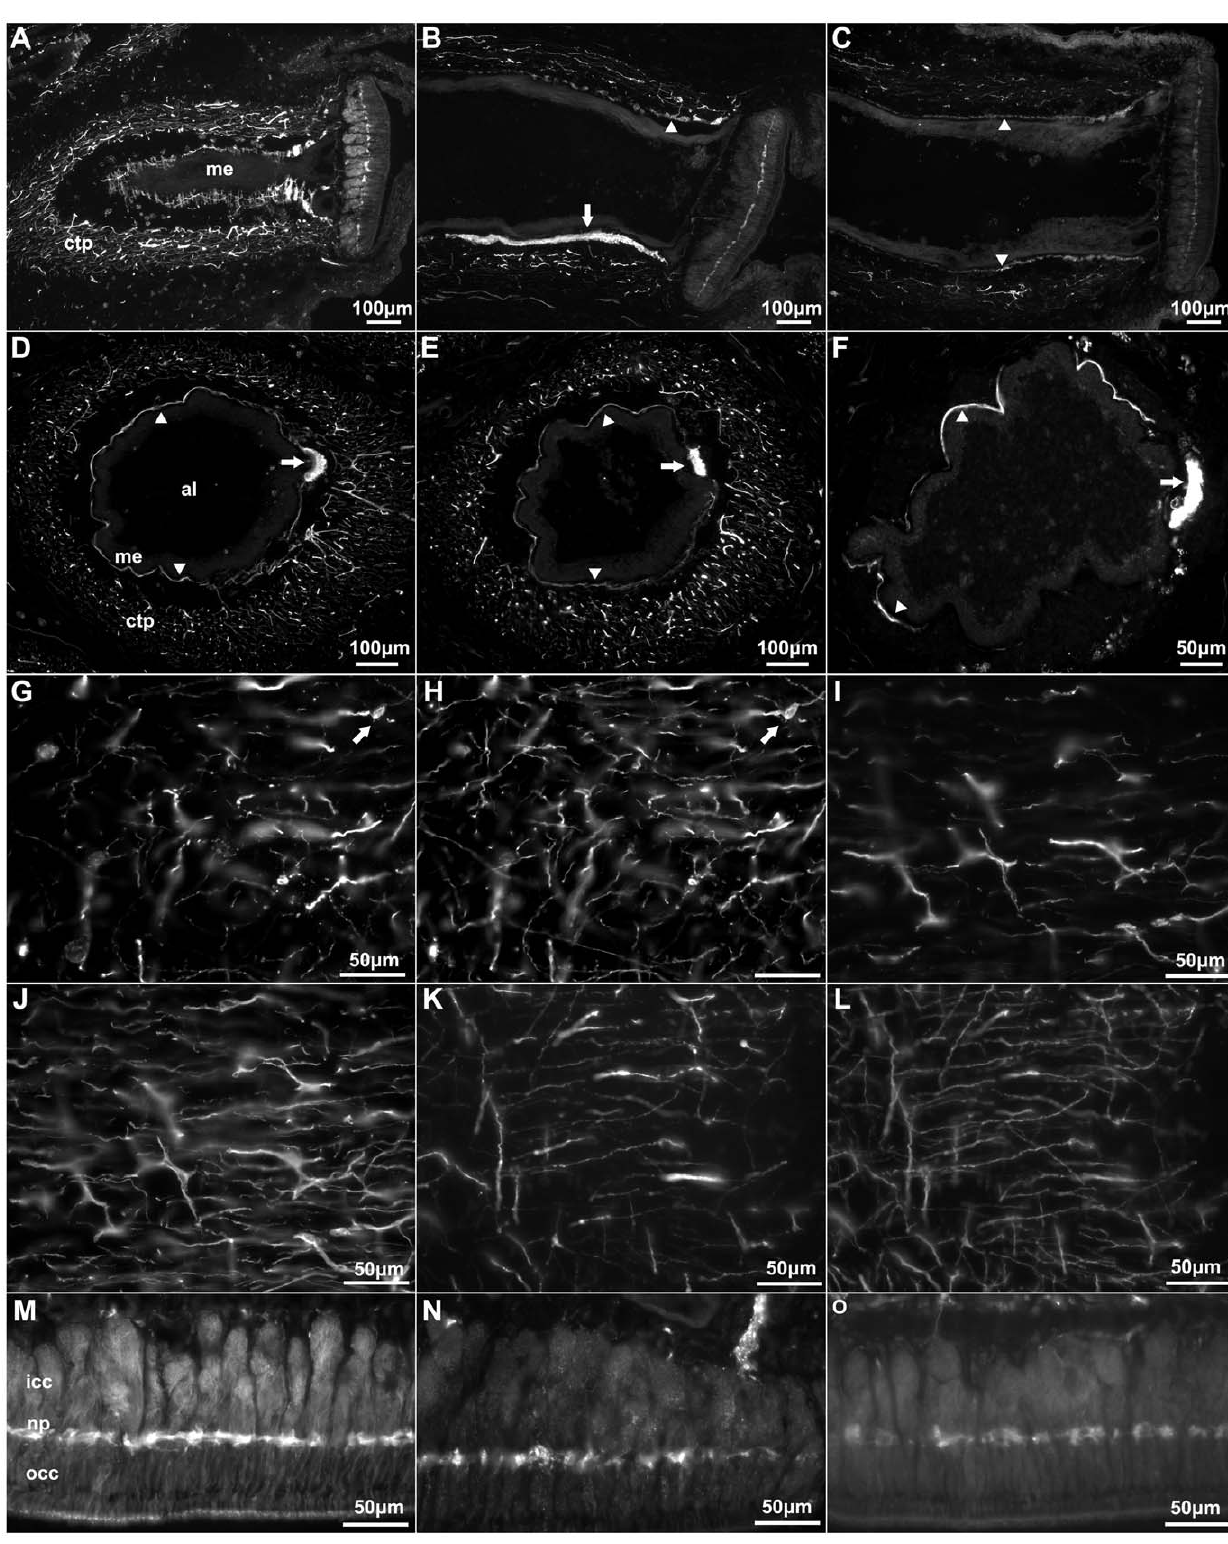
Figure 4. Anti-calbindin 1, anti-parvalbumin, and anti-calbindin 2 immunoreactivity in the podial nervous system of Holothuria glaberrima (Holothuroidea). Longitudinal and transverse sections through the tube feet showing immunoreactivity to anti-calbindin 1 (A,D,G,M), anti-parvalbumin (B,E,I,N), and anti-calbindin 2 (C,F,K,O) in the different subdivisions of the podial nervous system. (A–F) Immunoreactivity was observed with all markers in the podial nerve (arrows) and in the podial cylindrical fenestrated sheath (arrowheads). (G–L) Co-labeling of anti- calbindin 1 (G) and RN1 (H), anti-parvalbumin (I) and RN1 (J), and anti-calbindin 2 (K) and RN1 (L) was observed in fibers and cells (arrows) of the